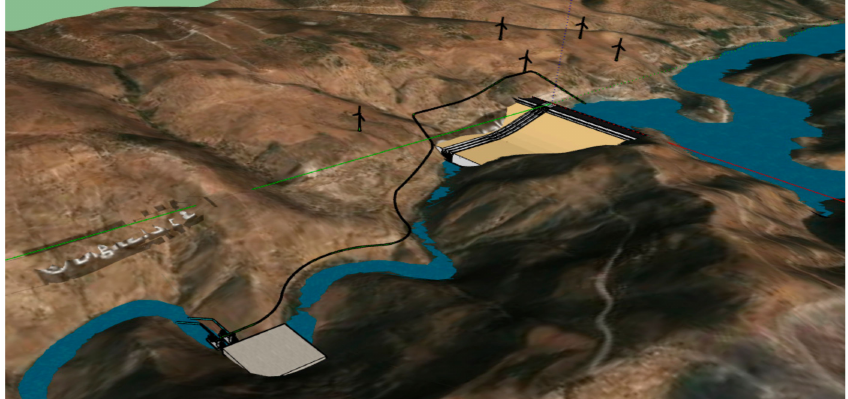
Figure 2. Layout of the of the wind farm connected with the hydropower plant at